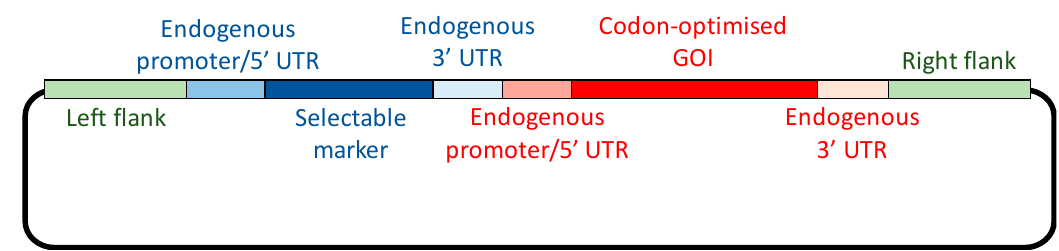
Figure 2. Transformation plasmid. A schematic of the required elements of a C. reinhardtii chloroplast transformation vector. UTR = untranslated region.